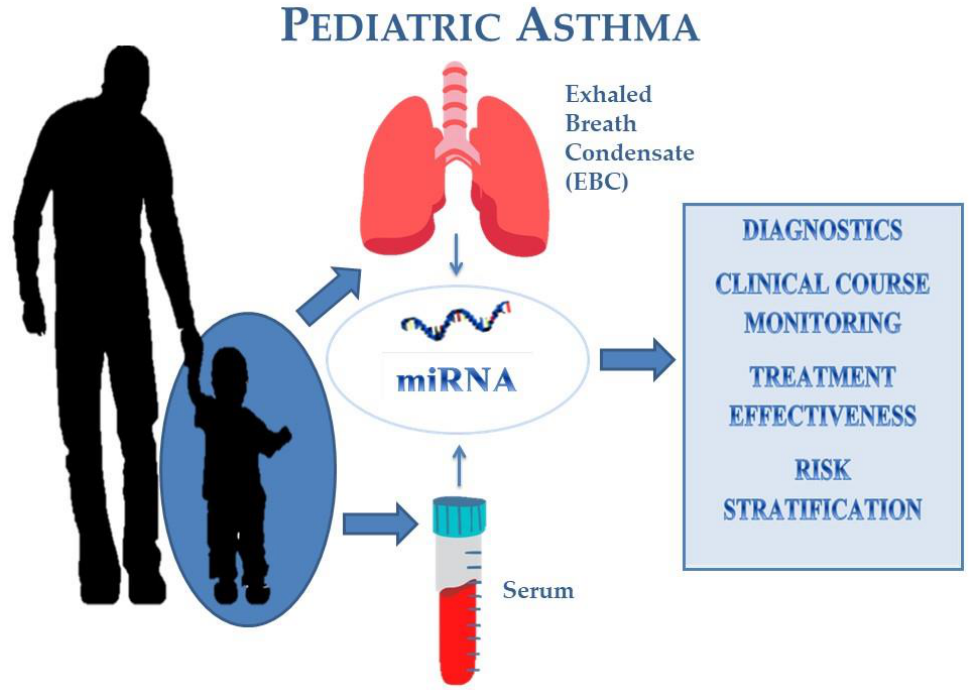
Figure 1. Serum and exhaled breath condensate-isolated miRNA and its potential role in asthma diagnostics and management in the pediatric population .